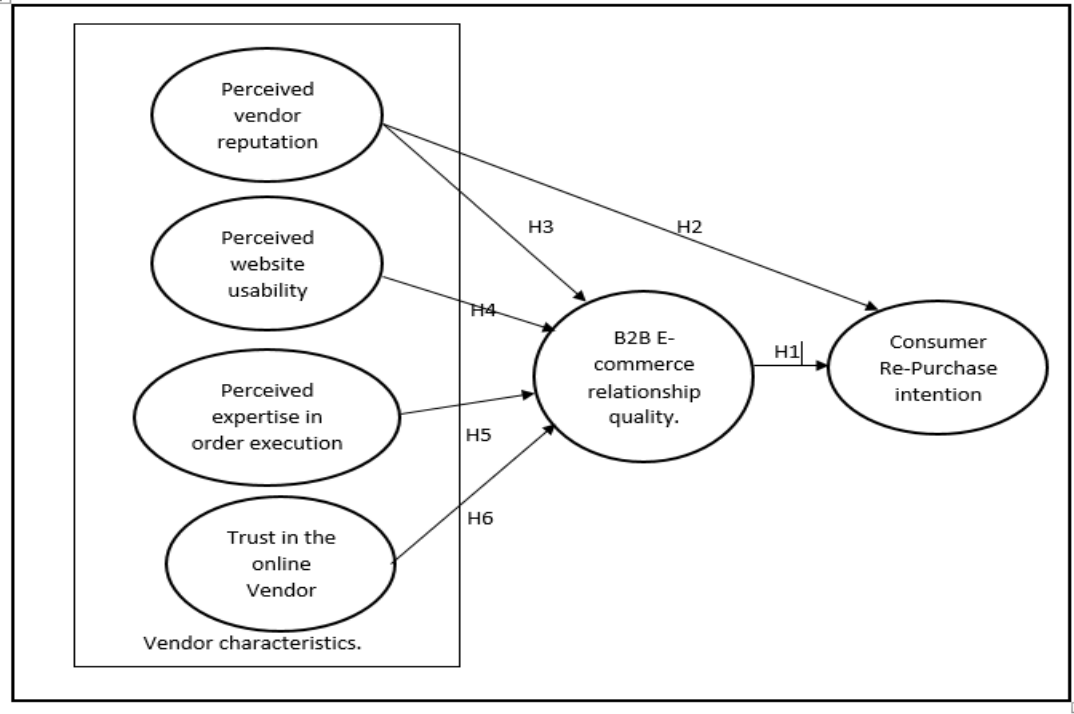
Figure1 : Conceptual